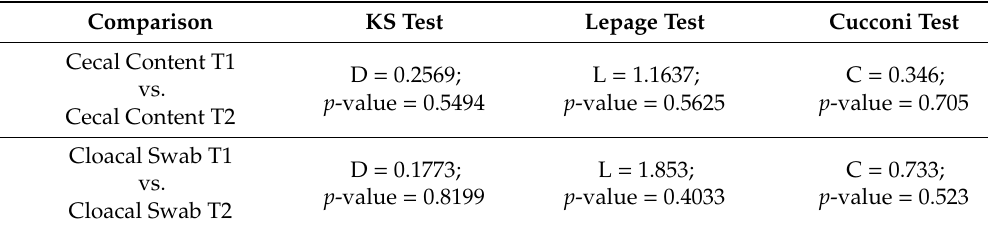
Table 2. Summary of the statistical test used in comparing the geometric mean distributions of dietary treatments within methods. Dietary comparisons are listed in the first column, with the statistical tests for the specified comparison in the adjacent columns. Each cell contains the respective test statistic and p -value for that